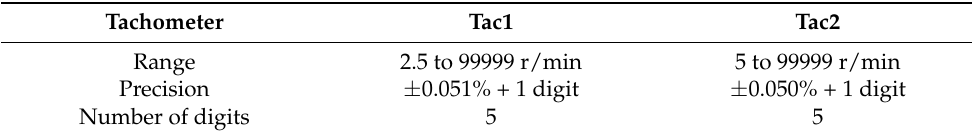
Table A4. Characteristic of the tachometers used in these tests.